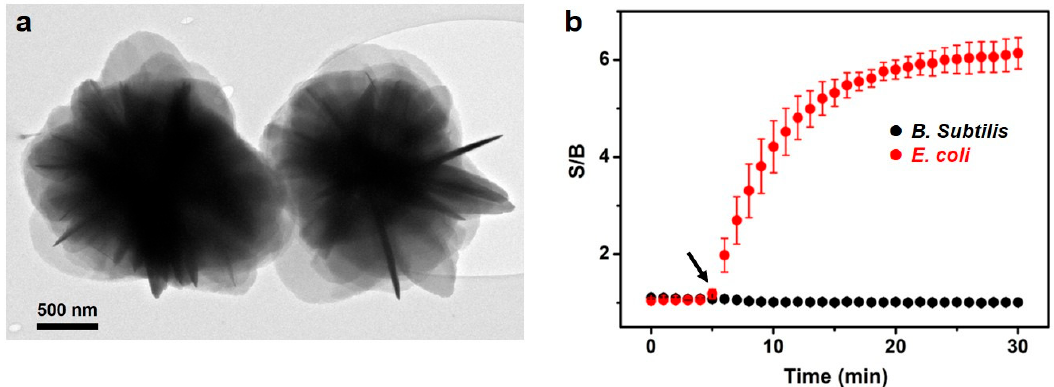
Figure 1. ( a ) Typical TEM image of 3D EC1. ( b ) The kinetic response of 3D EC1 / F-RS28 in the presence of CIMs from E. coli and B. subtilis cells (~ 10 6 CFU · mL − 1 ). λ ex / λ em = 494 / 518 nm. Data were obtained from the average of three parallel experiments, and the error bar is the standard deviation.